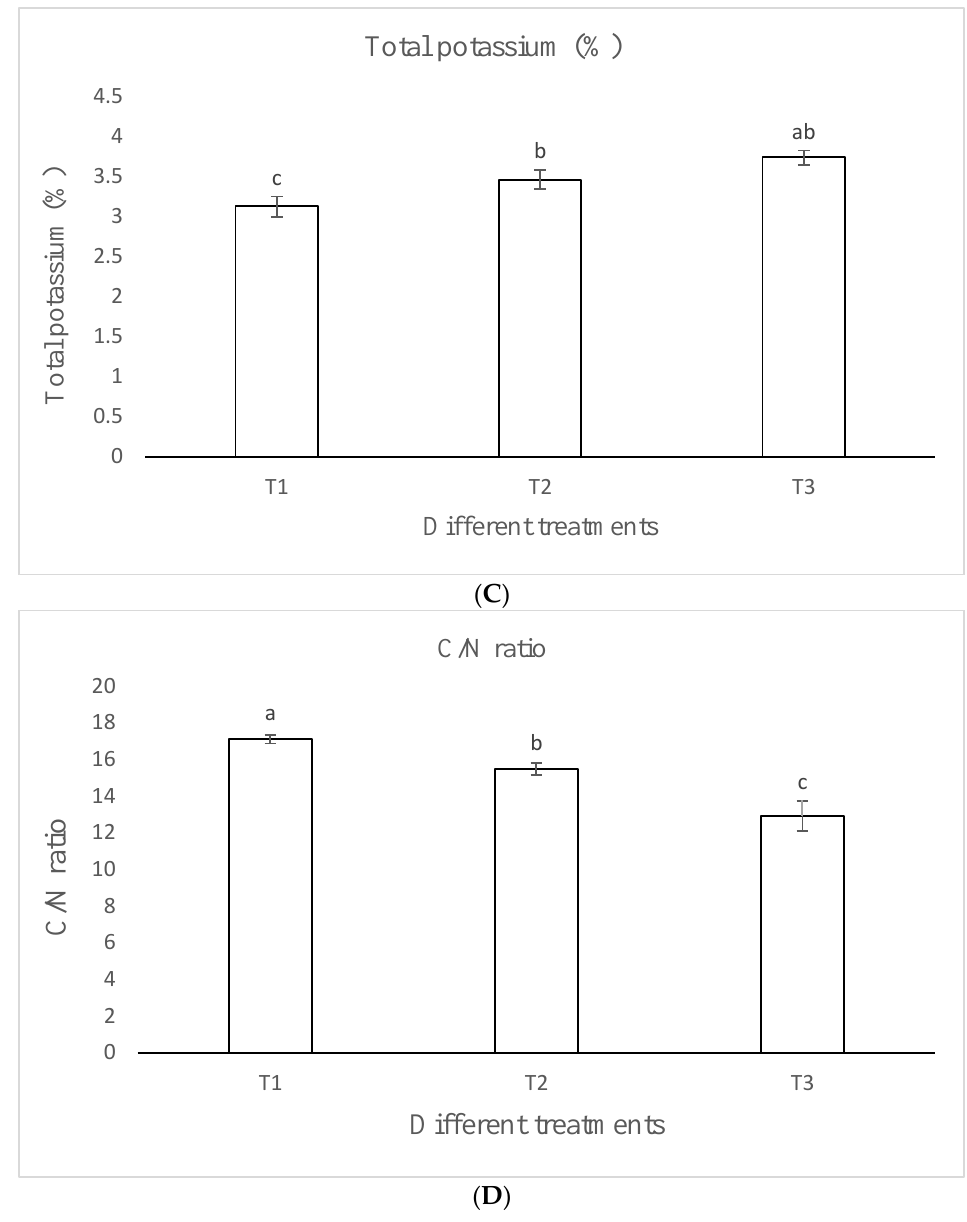
Figure 1. Total nitrogen ( A ), Total potassium ( B ), Total phosphorus ( C ), and C/N ratio ( D ) in different treatments after 60 days of vermicomposting with Eisenia fetida . Values are the mean of three replicates, and error bars indicate standard error (SD). The different letters between vermicomposts of different treatments denote statistical significance (ANOVA; Tukey’s HSD test at p < 0.05). T1 = macrophyte mixture only, T2 = macrophyte mixture + cow manure, T3 = macrophyte mixture + cow manure + nutrient supplements